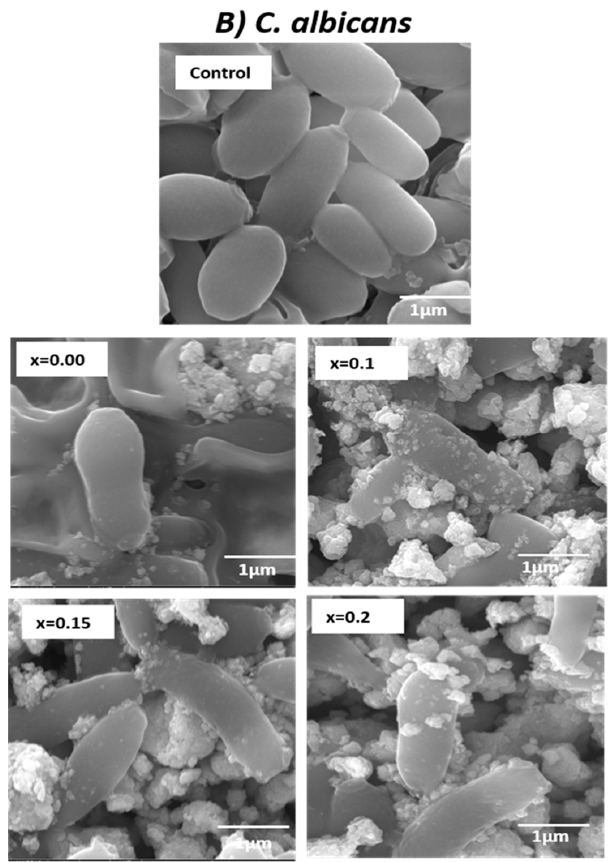
Figure 6. ( A ) SEM images for the morphogenesis of treated S. aureus with 1 mg/mL of CoNd x Fe 2 − x O